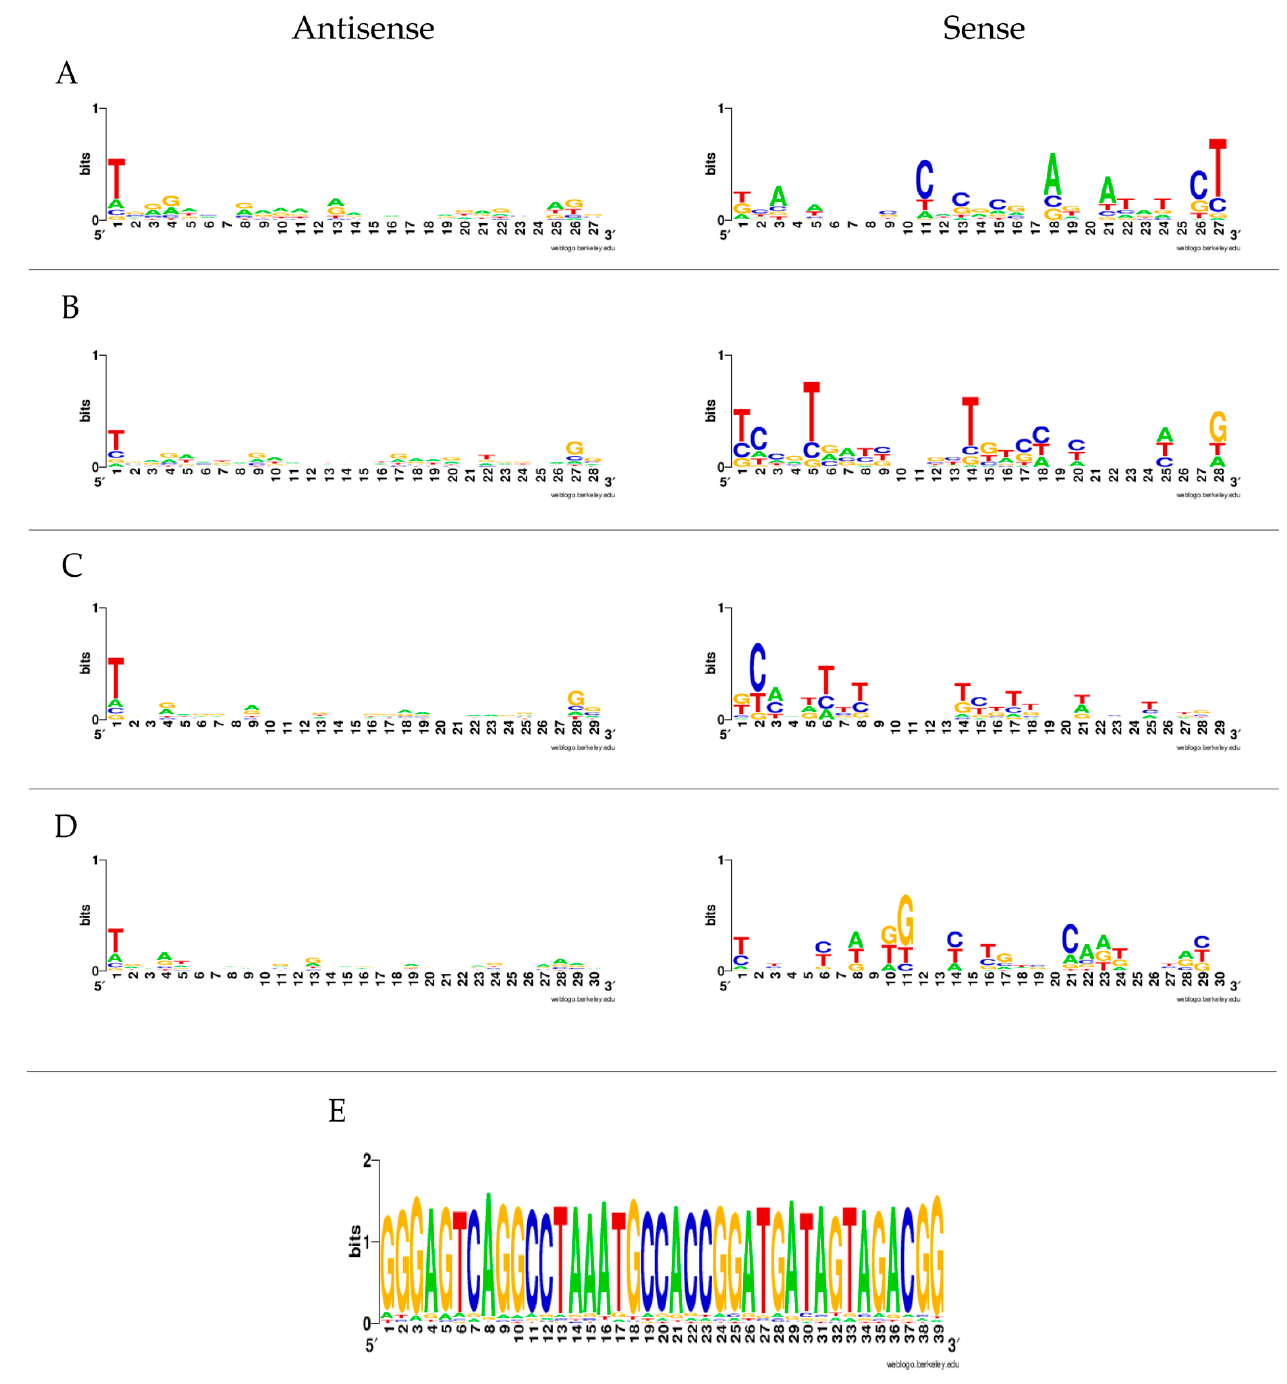
Figure 4. Nucleotide biases of the 27–30 and 39 nt long reads at 72 h p.i. of LamV. The sequences are in DNA format, so U is written as T. Reads derived from the antisense are shown in the left panel. Reads derived from sense strand are shown in the right panel: ( A ) 27 nt reads, ( B ) 28 nt reads, ( C ) 29 nt reads, ( D ) 30 nt reads, and ( E ) 39 nt long reads from the fourth hotspot in the LamV genome.